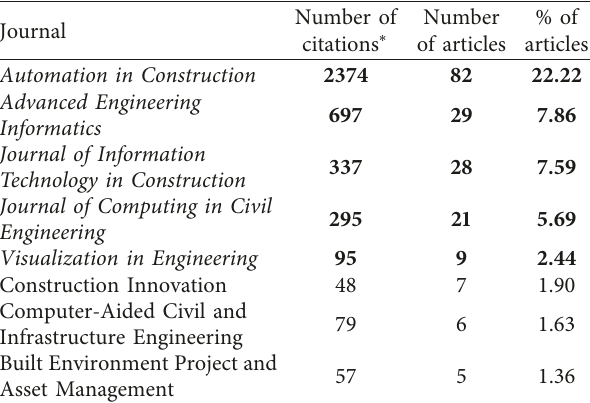
Table 6: The most cited